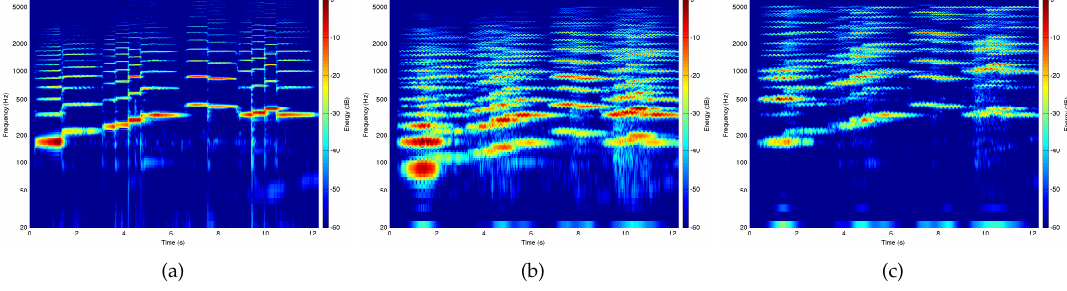
Figure 16. Beginning of “El Cant dels Ocells” [55], original and two different Hammondized settings. ( a ) Input signal; ( b ) Hammondized, “bassoon” registration; ( c ) Hammondized, “clarinet”